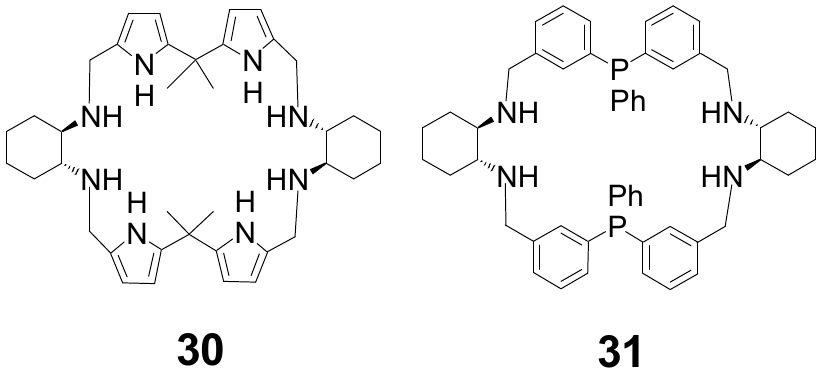
Figure 12. Extended [2 + 2] amine ligands for enantioselective catalysis. The enantiopure [2 + 2] imine and amine macrocycles 32 – 35 (Figure 13) have two chiral centers—chiral diamine fragment and chiral 1,1′-bi-2-naphthol (BINOL) fragment. These compounds were successfully used in enantioselective fluorescent recognition of mandelic acid and other chiral acids [78–80]. Macrocycle 35 was also used as a fluorescent probe selectively recognizing the mercury(II) cations [81]. Similar macrocyclic amine 36 acts as a selective fluorescent sensor for the detection of zinc(II) ions [82] as well as for the combined recognition of copper(II) ions and amino acids [83]. Figure 13. [2 + 2] macrocycles used as fluorescent detectors of guests. 3. [3 + 3]. Macrocycles The angle formed by the amine groups of DACH in combination with the linear alignment of aldehyde groups of 1,4-terephthalaldehyde leads to the preferred [3 + 3] con- densation product 37 of triangular shape (Figure 14), which was discovered in 2000 by Gawroński et al. and was called trianglimine [84]. This macrocyclic crude product can be